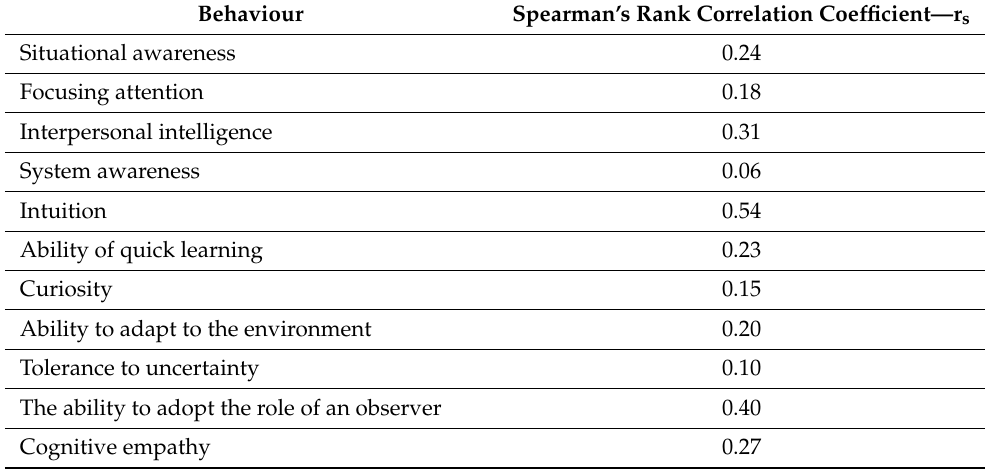
Table 4. Spearman’s index for behavior and skills in the VUCA